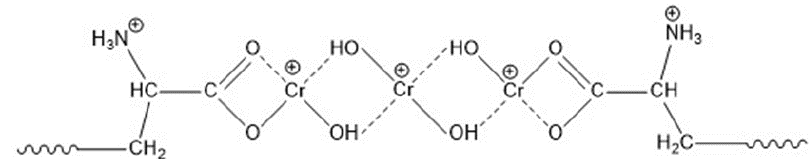
Figure 3. Chrome-tanned-based agent crosslinking with leather.